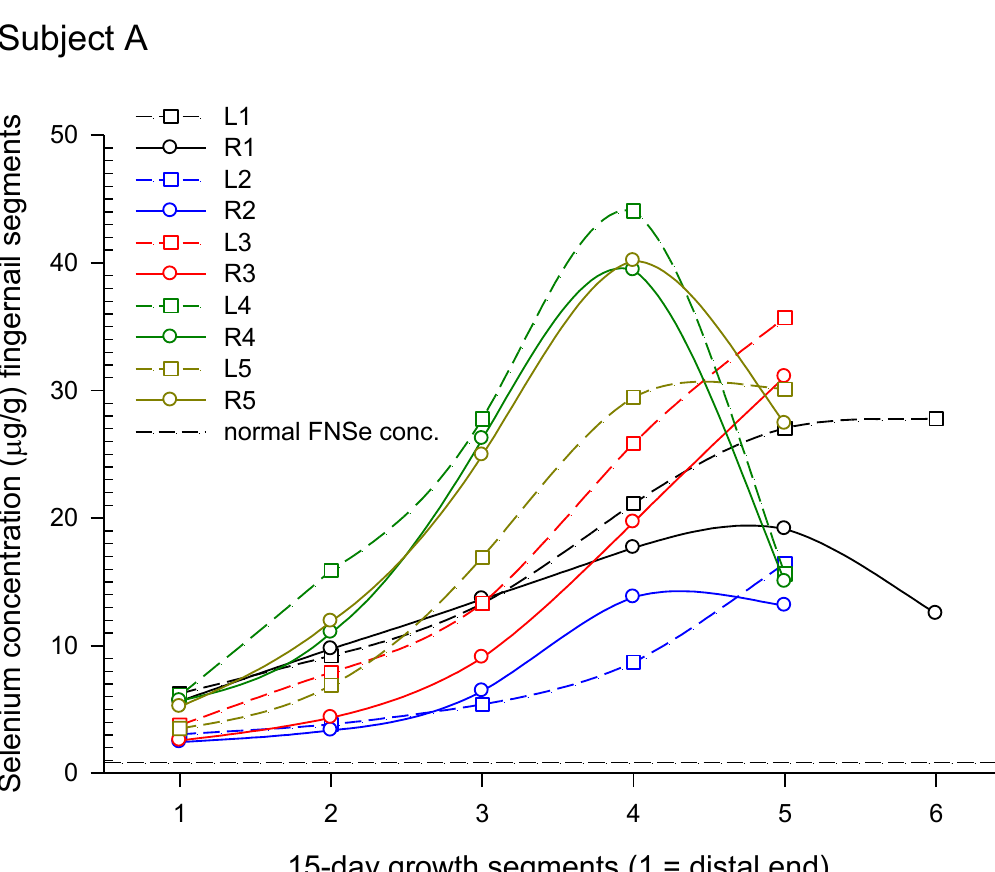
Figure 4. Temporal response in fingernail Se concentration (μg/g) from segmented onycholysitic fragments from all ten fingernails in two subjects who consumed 44 (Subject A ) and 32 (Subject B ) doses of misformulated TBF supplement products . These two subjects lost fragments from all 10 FNs that were approximately half the length of the entire nail. In the graph legends, the nails are identified as L (left), R (right) and 1 through 5 as thumbnail, index FN, middle FN, ring FN and little FN, respectively. These fragments were subdivided along the arc defined by the distal end of the fragment. Each segment was approximately 1.5 mm and was analyzed separately for Se. Each subject reported the TBF product lot numbers, total number of 1-ounce doses consumed, and the use period. From these data we compute that Subject A consumed 1,104,340 μg of Se over a 50 day period and Subject B consumed 831,456 μg over a 34 day period. The nail Se concentrations for the two subjects reflect their exposures (Subject A > Subject B; p = 0.0007). For both subjects, the highest Se concentrations were found in the ring FN (LR4). Then the Se concentrations